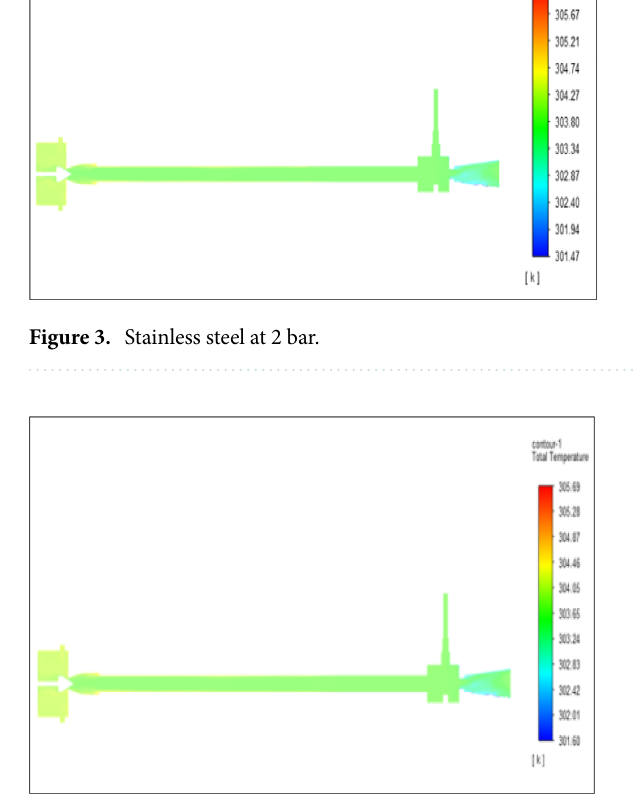
Figure 4. Brass at 2 bar.